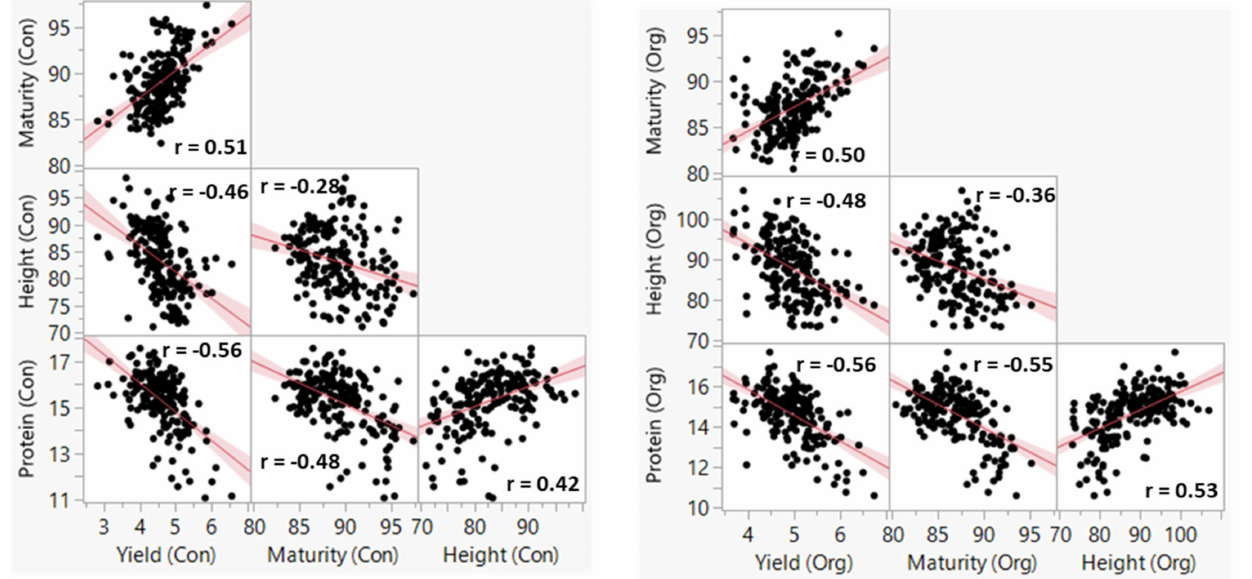
Figure 1. Scatter plots of the best linear unbiased estimators (BLUEs) of four agronomic traits computed from five conventionally and four organically managed environments. All correlations were significant at p < 0.01. The units of measurement were as follows: grain yield (t ha − 1 ), plant height (cm), maturity (d), and grain protein content